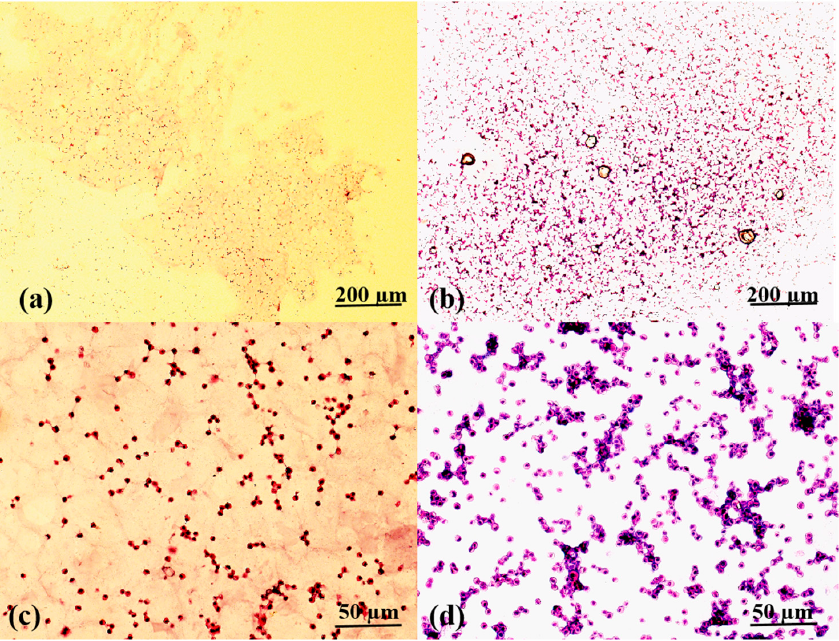
Figure 10. Haematoxylin and eosin (HE) staining of the cell-laden alginate-gelatin-interpenetrating polymer network (A-G-IPN): ( a ) a HE image of SH-SY5Y cell-loaded A-G-IPN hydrogel after 7 days of an in vitro culture. ( b ) A HE image of SH-SY5Y cell-loaded A-G-IPN hydrogel after 14 days of an in vitro culture. ( c ) A magnified image of ( a ), ( d ) A magnified image of ( b ).